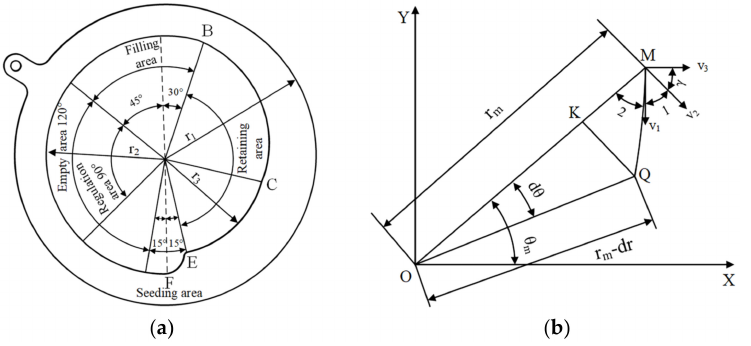
Figure 4. The structure of the seeding quantity adjusting mechanism. ( a ) Angle design; ( b ) local enlarged drawing. Point B is the starting point of adjustment, point C is the end point of adjustment, point E is the starting point of seeding, and point F is the ending point of